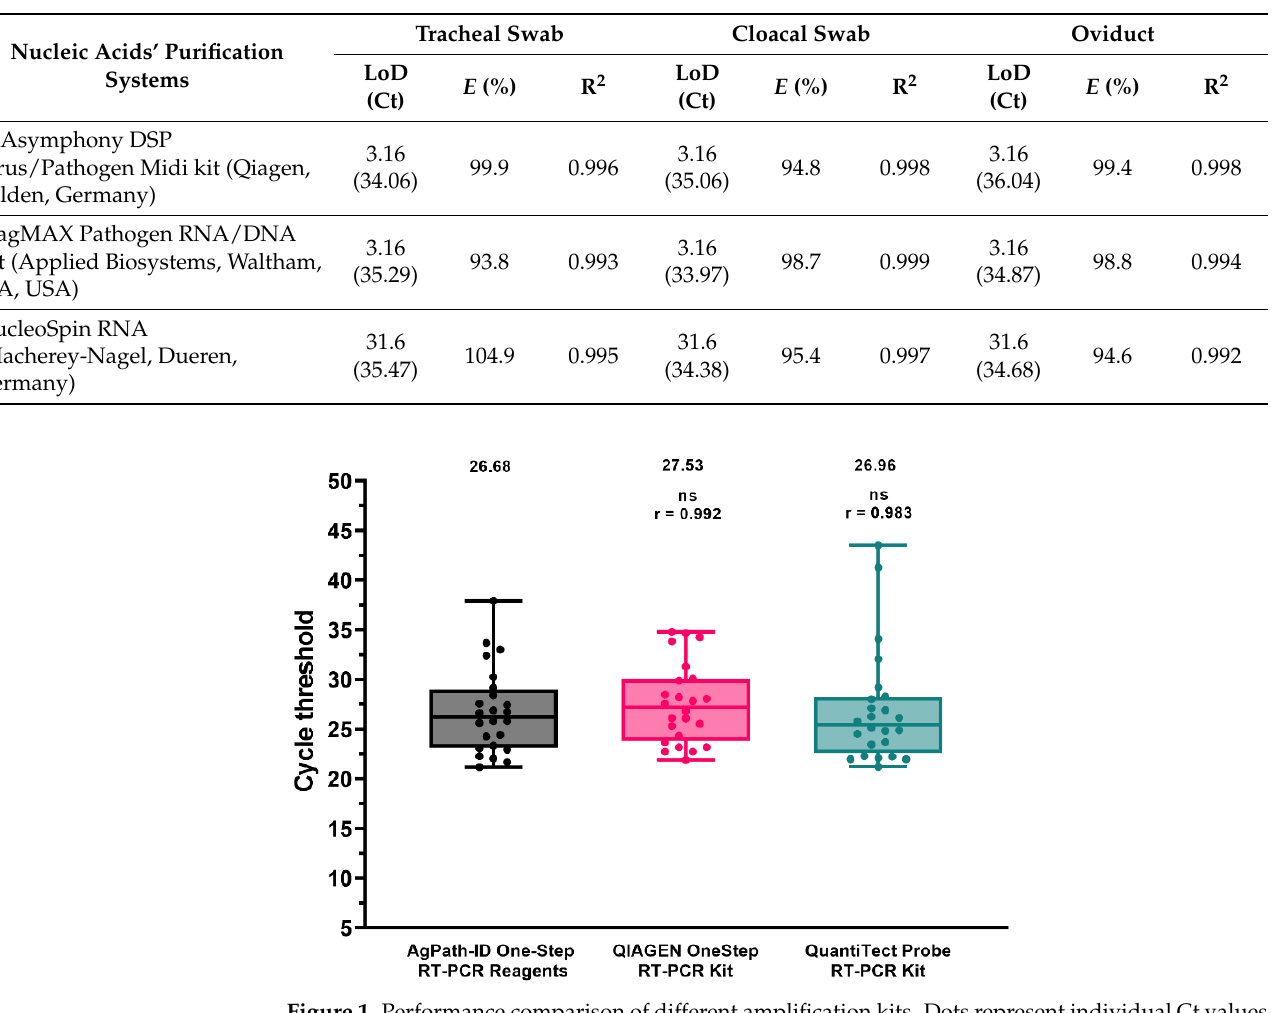
Table 5. Analytical sensitivity in tracheal swabs, cloacal swabs and oviduct homogenate spiked with H9 G1 (A/chicken/Nigeria/19VIR8424-15/2019/H9N2) using different nucleic acids extraction kits. The LoD is expressed as EID 50 /100 μL and mean Ct values. For each dilution series, the amplification efficiency E (%) and the coefficient of correlation R 2 are reported.